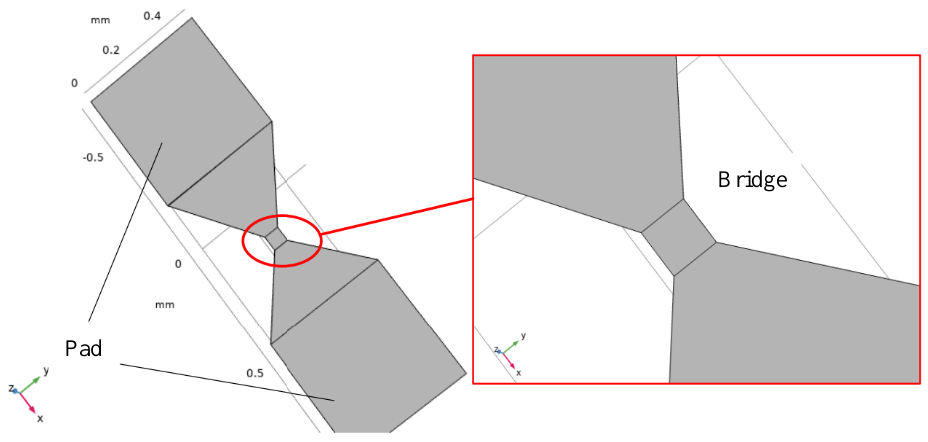
Figure 6. Solid-state ON-OFF multi-physical field simulation model.